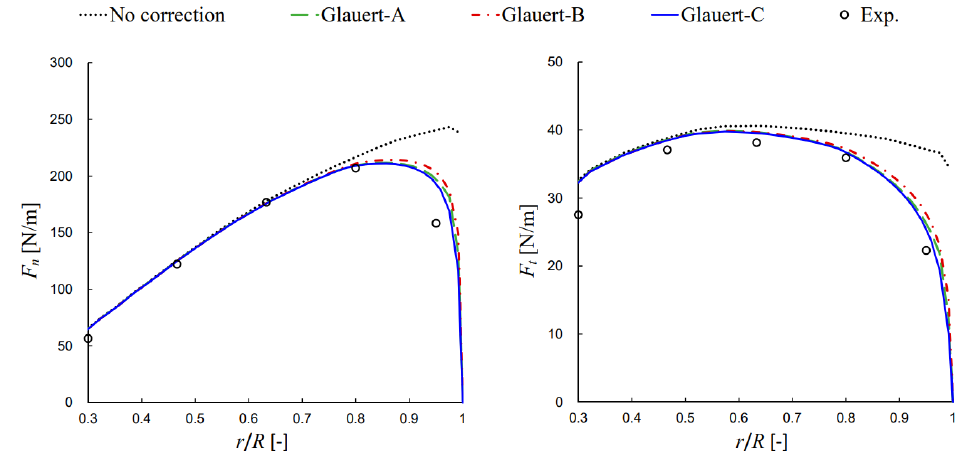
Figure 8. Effect of tip-loss correction on the normal ( F n ) and tangential ( F t ) forces along the NREL Phase VI blade in an AD simulation. Reprinted from Ref. [81] under Creative Commons Attribution CC BY